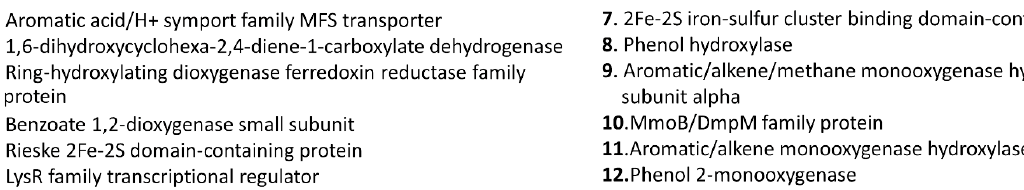
Figure 4. The organisation of the genes putatively involved in isoprene degradation in Alcaligenes sp. strain 13f, presented in comparison with the iso gene organisation in the reference isoprene degraders: Rhodococcus AD45, Sphingopyxis OPL5, and Variovorax WS11 [18–20]. The arrows represent the orientation of the genes. The dotted frames surrounding the gene names are to remind the reader of the putative functional homologues involved in isoprene degradation, with the percent identity to the protein sequences of Variovorax WS11 shown below. The bottom-row diagram shows the gene arrangement in Alcaligenes sp. strain 13f according to the closest proteins identified by NCBI protein database.